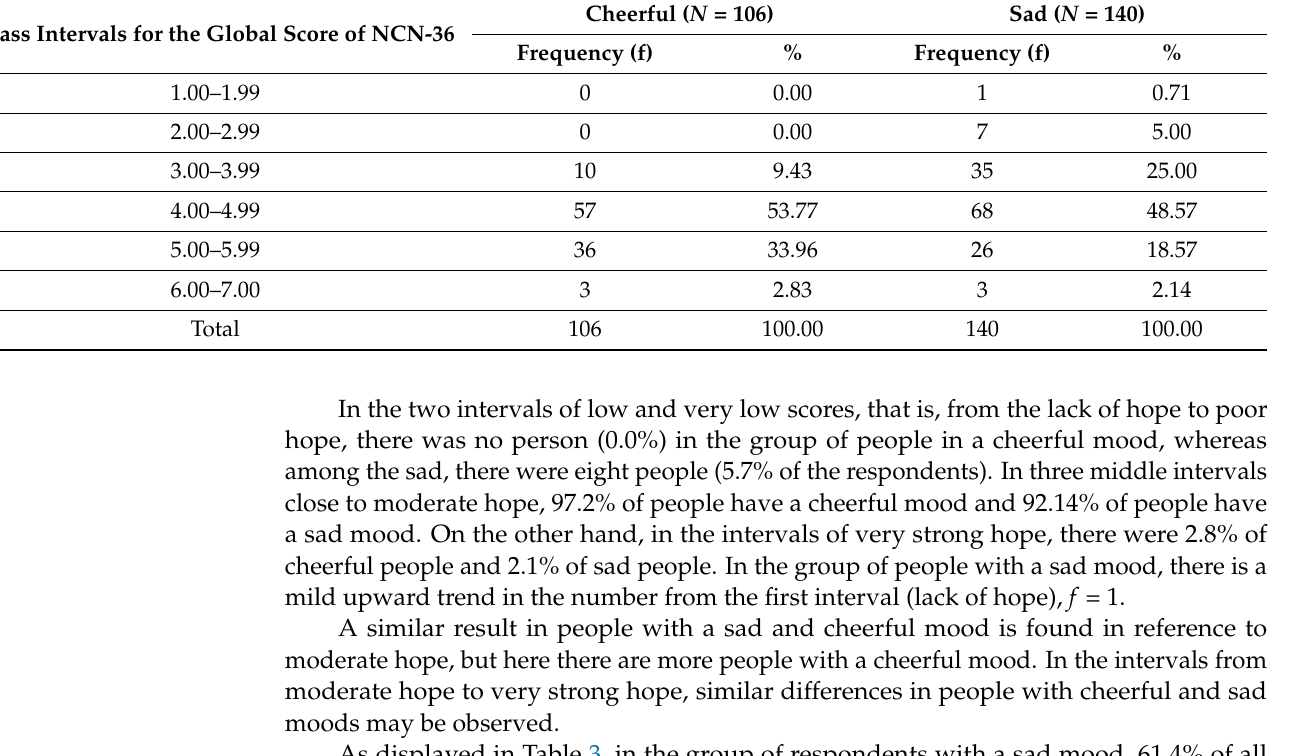
Table 2. Distribution of the percentages of global results for hope in people in the terminal phase of cancer of the studied group N =